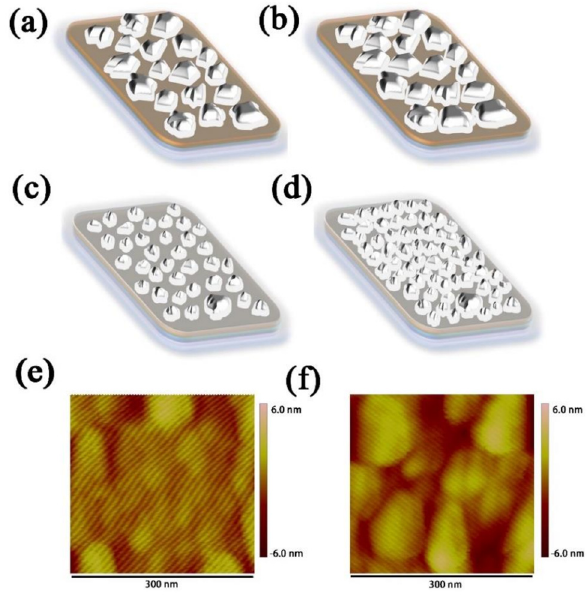
Figure 4. Schematic of the ultra − thin Ag film morphology changing with the increase in film thickness on ( a , b ) the MoO 3 film and ( c , d ) the Ag/Ge film. AFM images of ( e ) the Ag/Ge/Ag film and ( f ) the single Ag